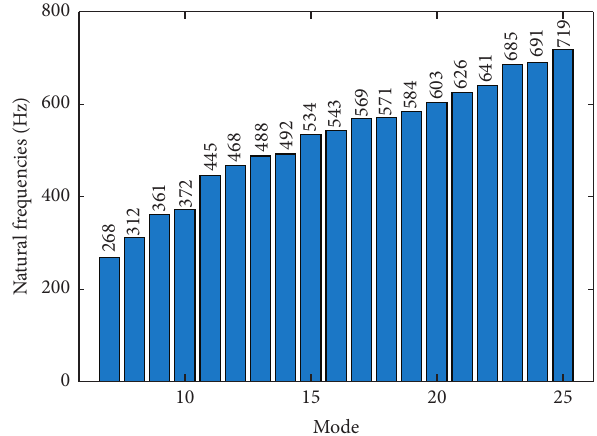
Figure 7: Housing natural